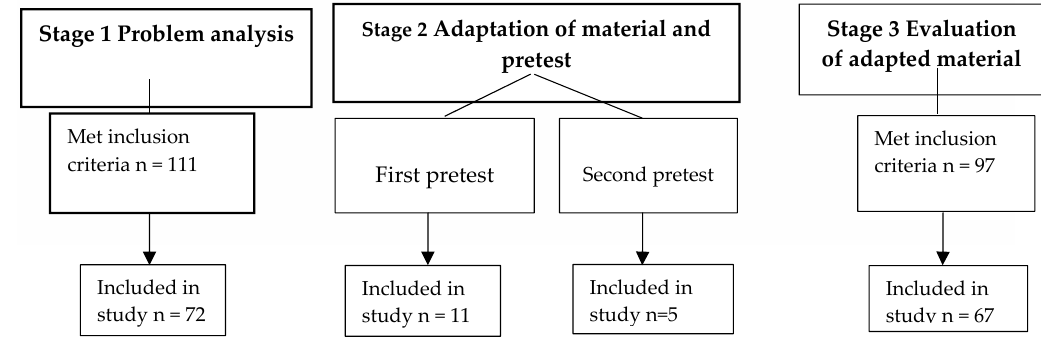
Figure 2. Inclusion study population. Table 3. Background characteristics stage 1 and 3 (n =